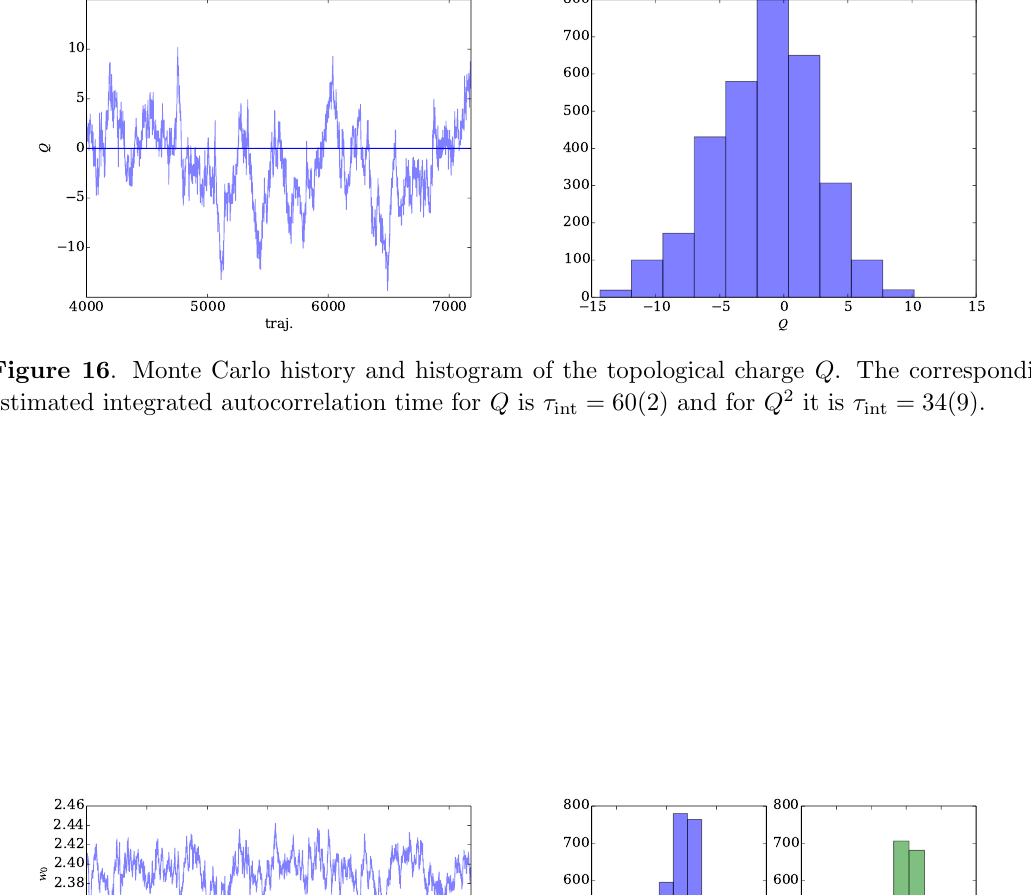
Figure 17 . Left : Monte Carlo history of Wilson (cid:13)ow scales w 0 and corresponding histograms of w 0 and